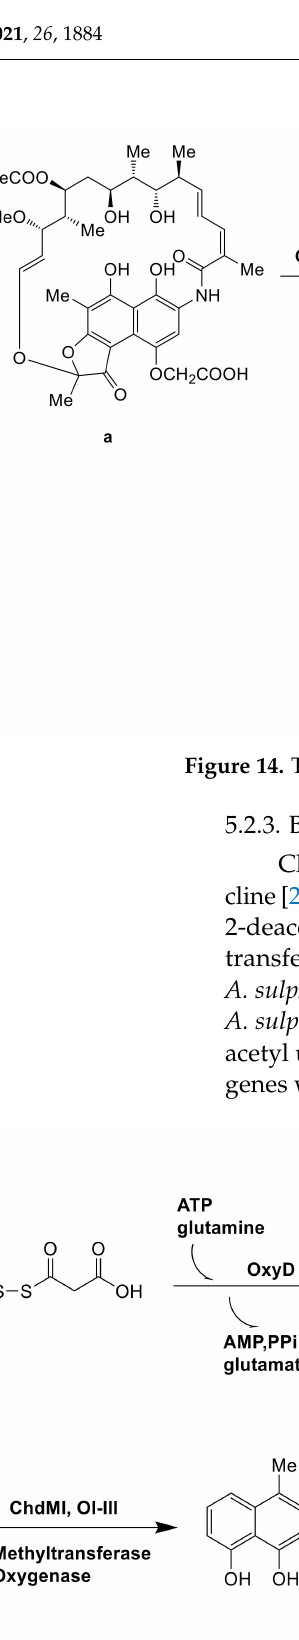
Figure 15. The biosynthesis pathway of CDCHD